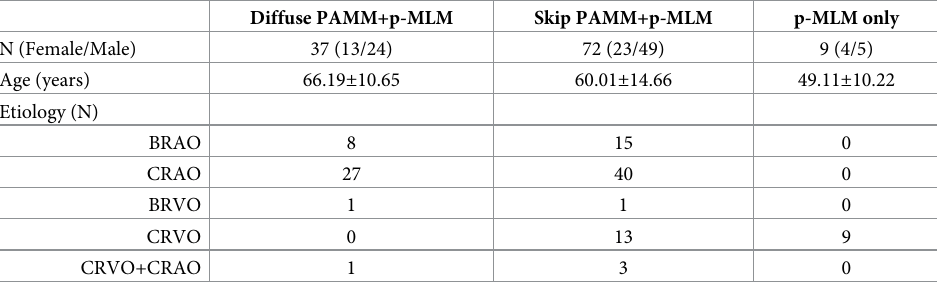
PAMM: paracentral acute middle maculopathy, p-MLM sign: prominent middle limiting membrane sign, BRAO: branch retinal artery occlusion, CRAO: central retinal artery occlusion, BRVO: branch retinal vein occlusion, CRVO: central retinal vein